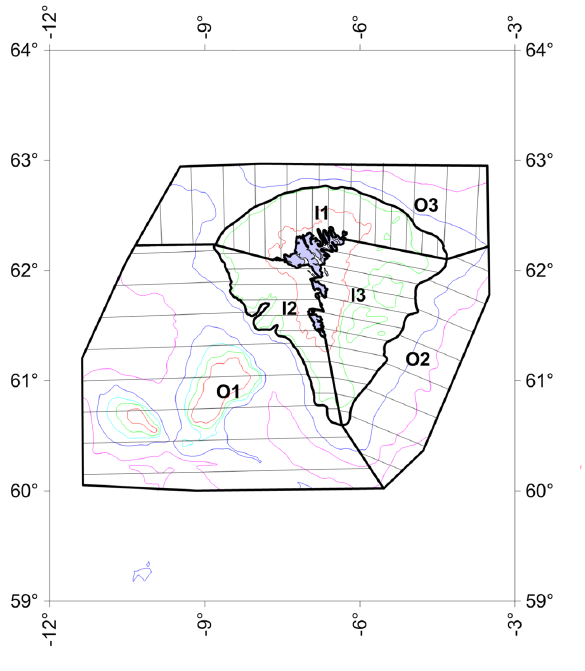
Figure 2. Overview of planned survey strata and transect lines for the 2010 aerial survey around the Faroe Islands. The letters identify the 6 strata. Depth contours shown (in m) are 100 (red), 200 (green), 300 (black), 500 (purple) and 1,000